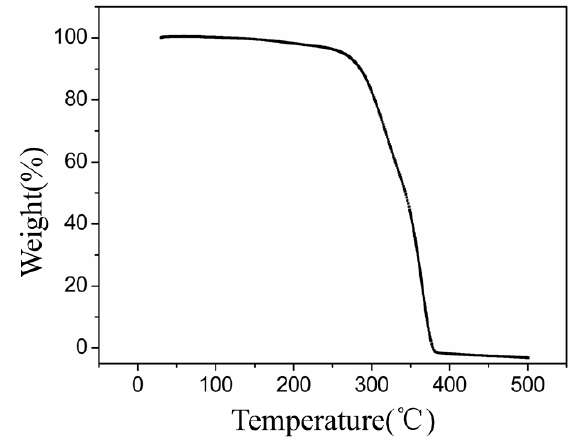
Figure 2. TGA curves of PLA (the PLA was synthesized in toluene-THF (toluene/THF = 2), Lac-OCA concentration = 1.67 mol/L, M/I = 150, temperature = 25 °C and reaction time = 4 h).